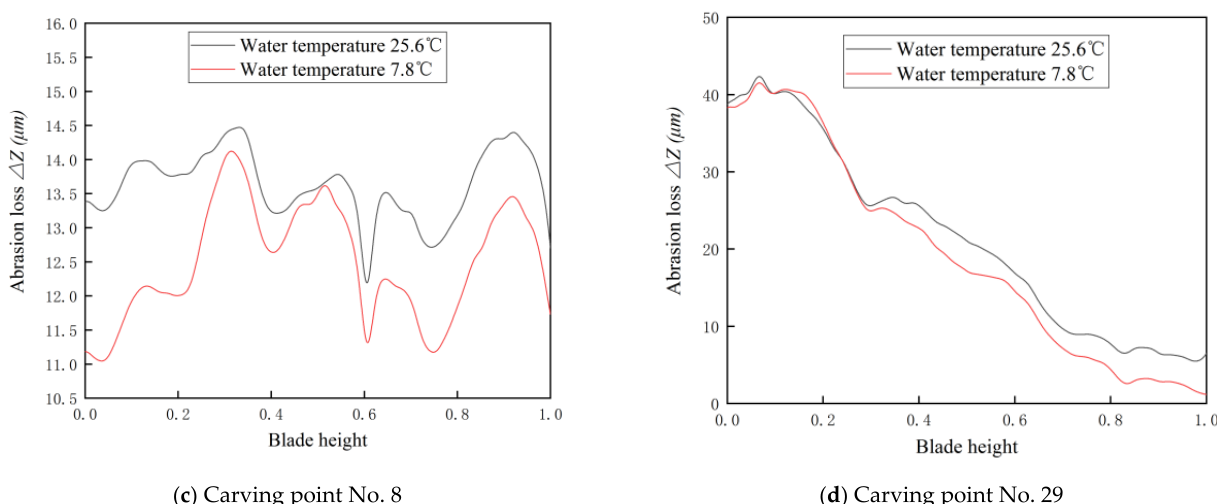
Figure 21. ( a – d ) Wear amount at different scoring points ( P = 42.8 MW).